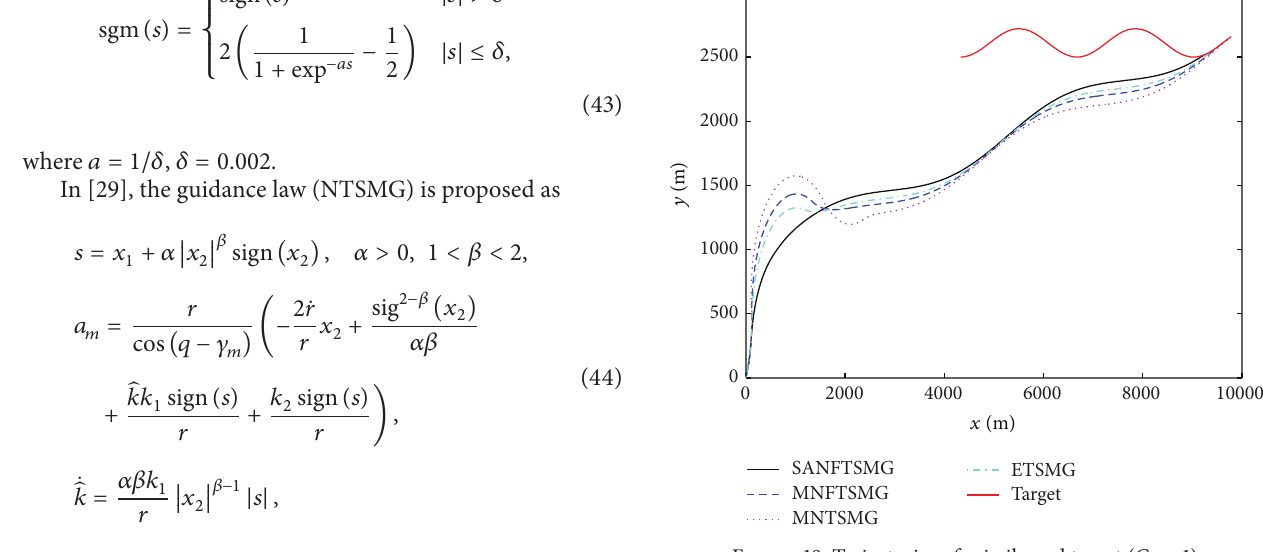
Figure 18: Trajectories of missile and target (Case 1).